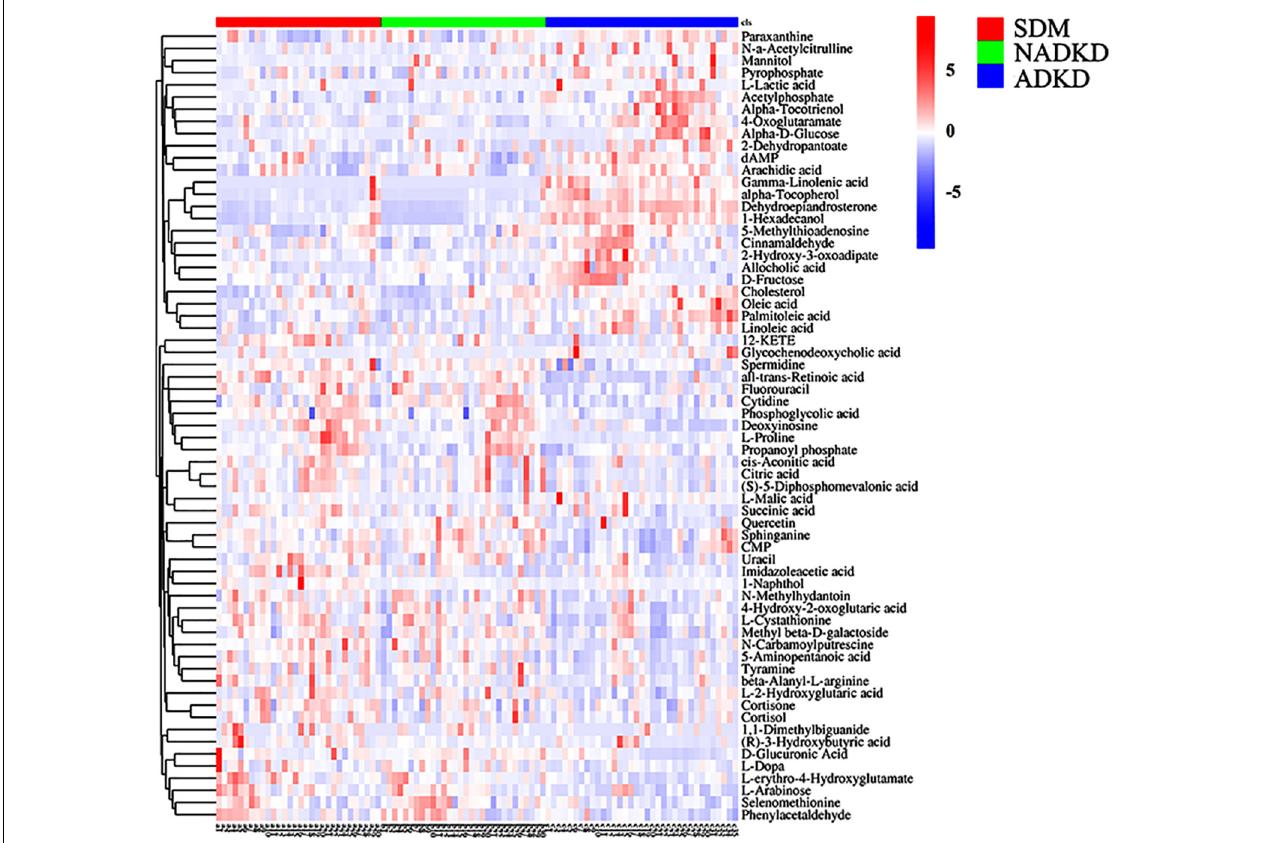
FIGURE 3 | Differential metabolite heat map. The columns represent samples, the rows represent metabolites, and the relative content of the metabolites is displayed by color. The heat map shows differential metabolites among SDM, NADKD, and ADKD